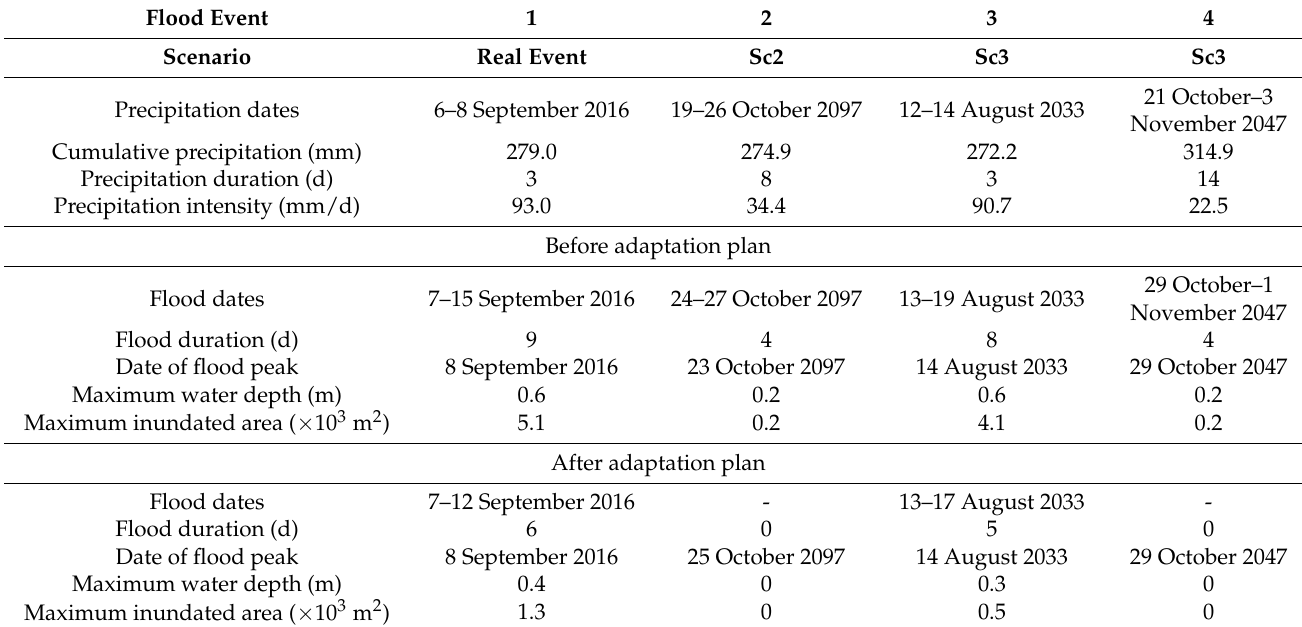
Table 3. Investigated flood events at the archaeological site of Ancient Messene.